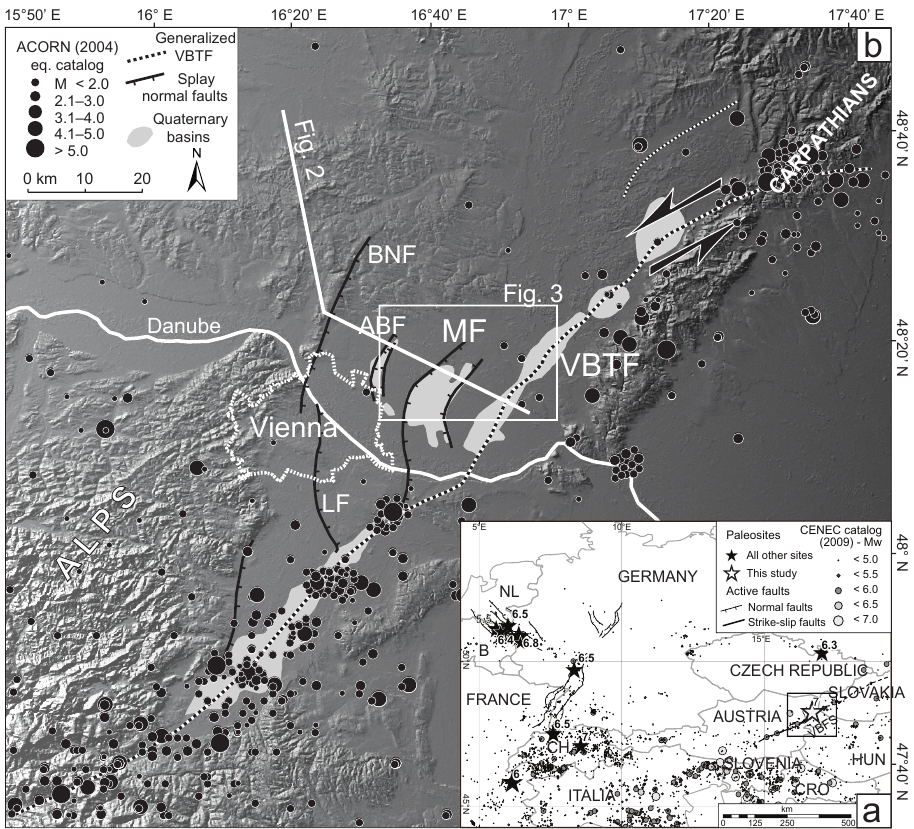
Figure 1. (a) Major earthquakes from historical, instrumental, and palaeoseismological data in intra-plate central Europe. Historical and in- strumental seismicity is based on the CENEC catalogue by Grünthal et al. (2009). Palaeoseismological study sites are compiled from Camel- beeck and Meghraoui (1998), Camelbeeck et al. (2000),Camelbeeck et al. (2007), Meghraoui et al. (2001), Vanneste and Verbeeck (2001), Van den Berg et al. (2002), Peters et al. (2005) and Štepancíková et al. (2010). Labels indicate the magnitudes of the largest palaeoearthquakes observed at the respective site. Black box shows area of the close up in panel (b) . VBFS is the Vienna Basin Fault System. (b) Active faults (black solid and dashed lines), seismicity (black circles), and Quaternary basins (light grey areas) within the Vienna Basin (Austria) plot- ted on a shaded DEM (90 × 90m resolution, SRTM data). Seismicity is based on the ACORN catalogue (ACORN, 2004). The borders of the Austrian capital, Vienna, are outlined by a dashed white line. Modified after Beidinger and Decker (2011). VBTF is the Vienna Basin Transfer Fault. Important normal splay faults of the VBTF: ABF is Aderklaa–Bockfliess Fault, BNF is Bisamberg–Nussdorf Fault, LF is Leopoldsdorf Fault, and MF is Markgrafneusiedl Fault. White box shows the location of Fig. 3a, while the white line is the position of the cross section of Fig.